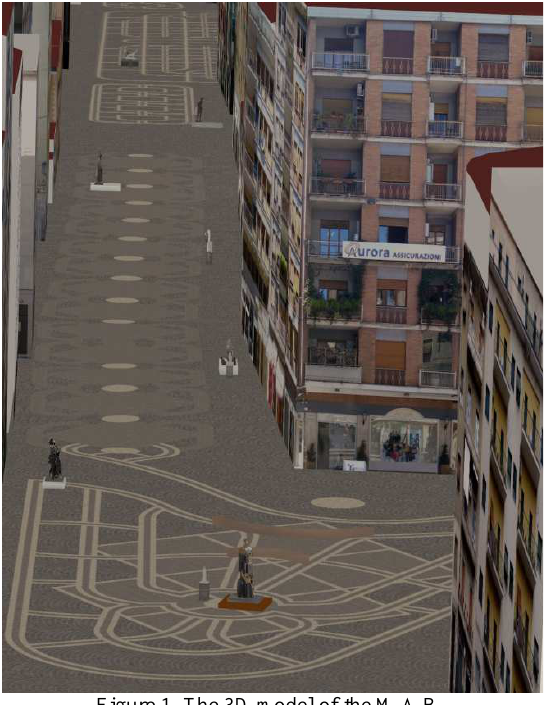
Figure 1. The 3D model of the M.A.B.